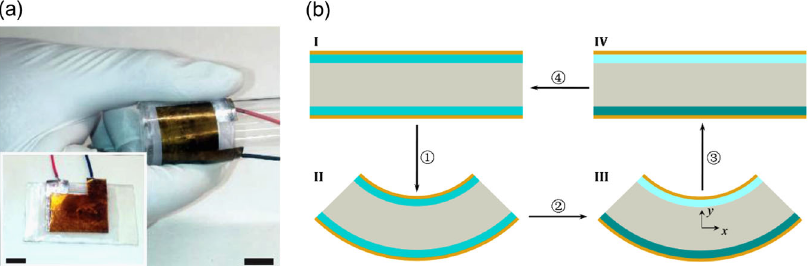
Fig. 6 a An image of the actual device with a bending unit. 94 Scale bars: 1 cm. b Schematic illustrating working principle of the mechanical energy harvester ( gold : current collector, eucalyptus : electrode with high Li concentration, cyan : electrode with low Li concentration, gray :